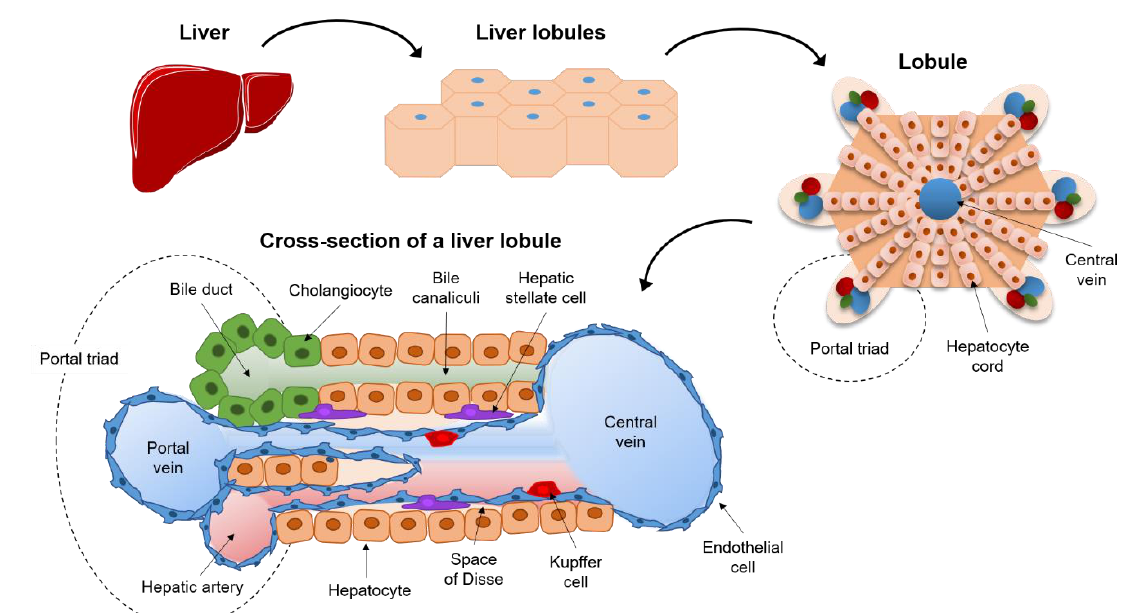
Figure 3. Schematic representation of liver lobule. The liver is composed of hexagonal functional unit known as lobule homogeneous throughout all the liver. Hepatic stellate cells give structural support to the endothelial cells which regulate the exchange with blood. Kupffer cells are the macrophage of the liver and responsible for the initial immune response in case of an insult. The hepatocytes represent the metabolic factory of the liver and organized according to their function. This anatomical configuration is the main challenge of tissue engineering.